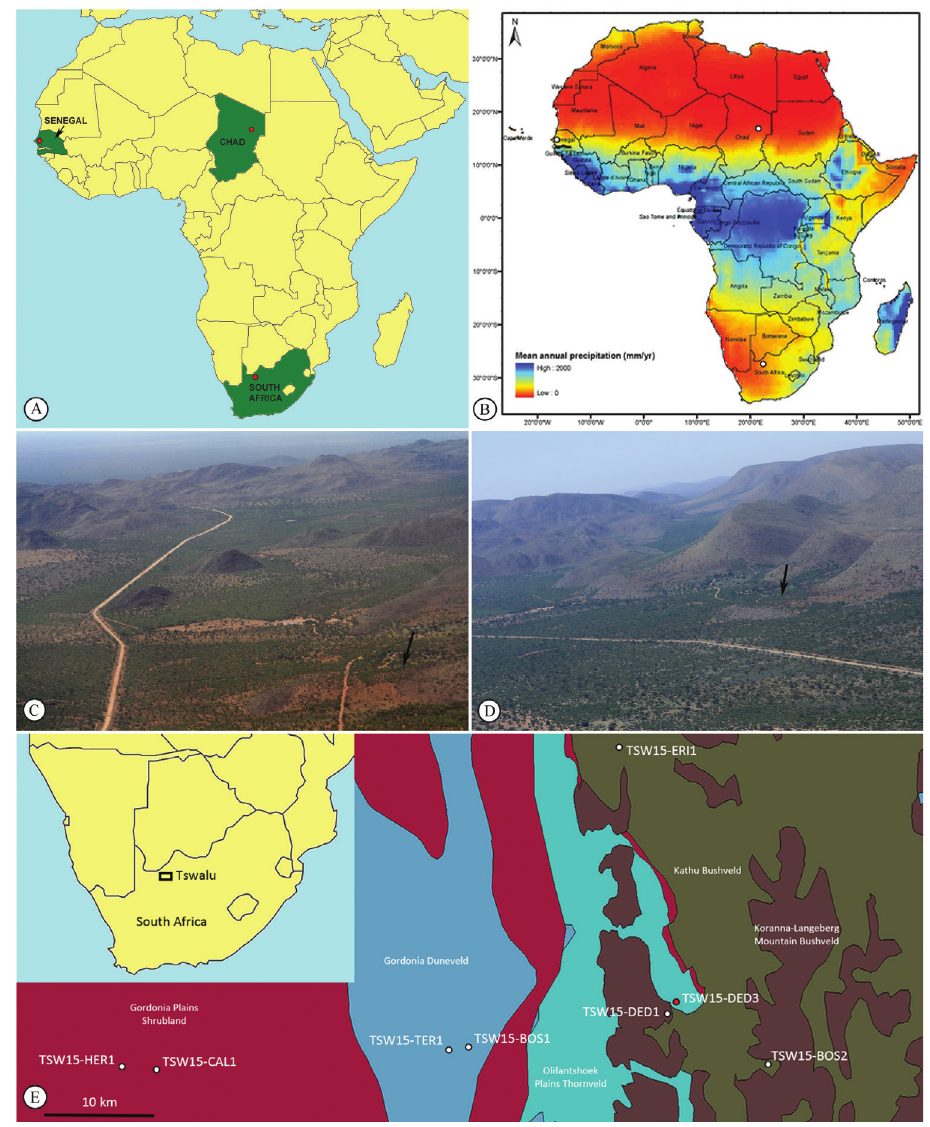
Figure 6. Spathioplites phreneticus A political distribution map. Only known from three localities (depict- ed by red circles) one each in Chad, Senegal and South Africa B distribution localities (depicted by white circles) mapped onto African precipitation patterns. Data source: ERA-Interim corrected with GPCP v2.1; period: 1979–2010. After Masih et al. 2014 and Trambauer et al. 2014 C habitat South African sampling site locality TSW15-DED3 in Tswalu Kalahari Game Reserve, aerial view from North in February 2016 after summer rains (locality arrowed) D habitat South African locality TSW15-DED3 in Tswalu Kalahari Game Reserve, aerial view from East in February 2016 after summer rains (locality arrowed) E sampling localities in Tswalu Game Reserve plotted onto vegetation map after Mucina and Rutherford (2006); red circle depicts S.phreneticus locality TSW15-DED3, white circles depict other sampling